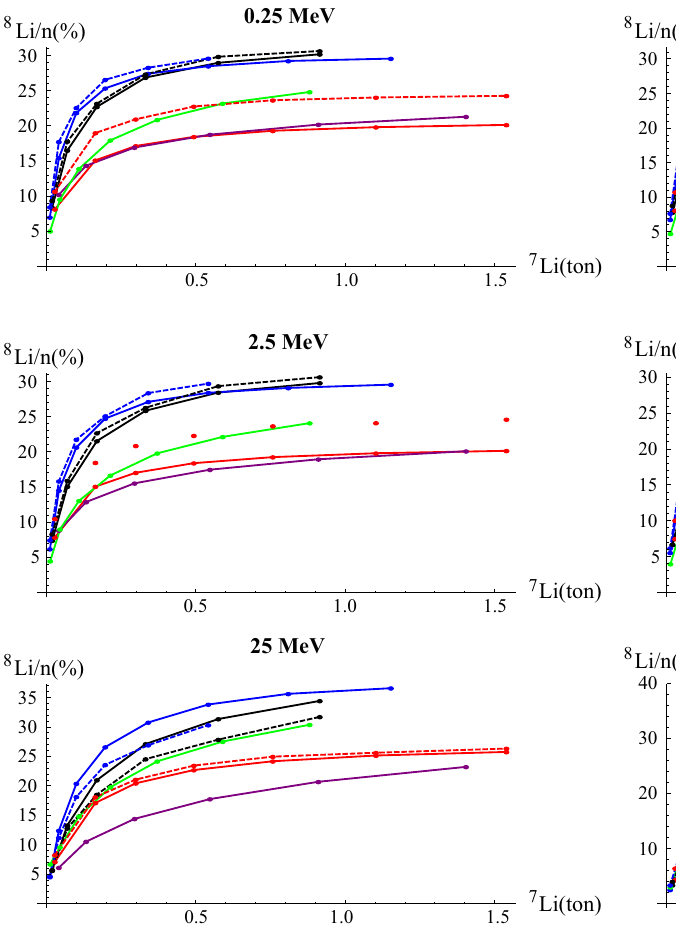
Fig. 1 The 8 Li / neutron ratio for monochromatic neutrons at various energies. The black, blue, red, purple and green curves represent the LiOD, LiOD · D 2 O, solution, metallic Li and FLiBe converters respec-